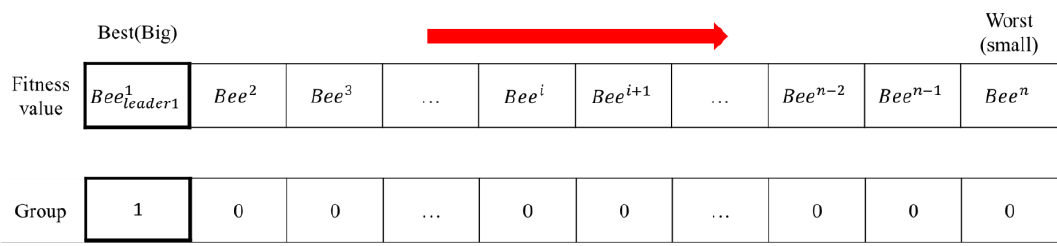
Figure 12. Highest fitness value of particles is set as new group leader.